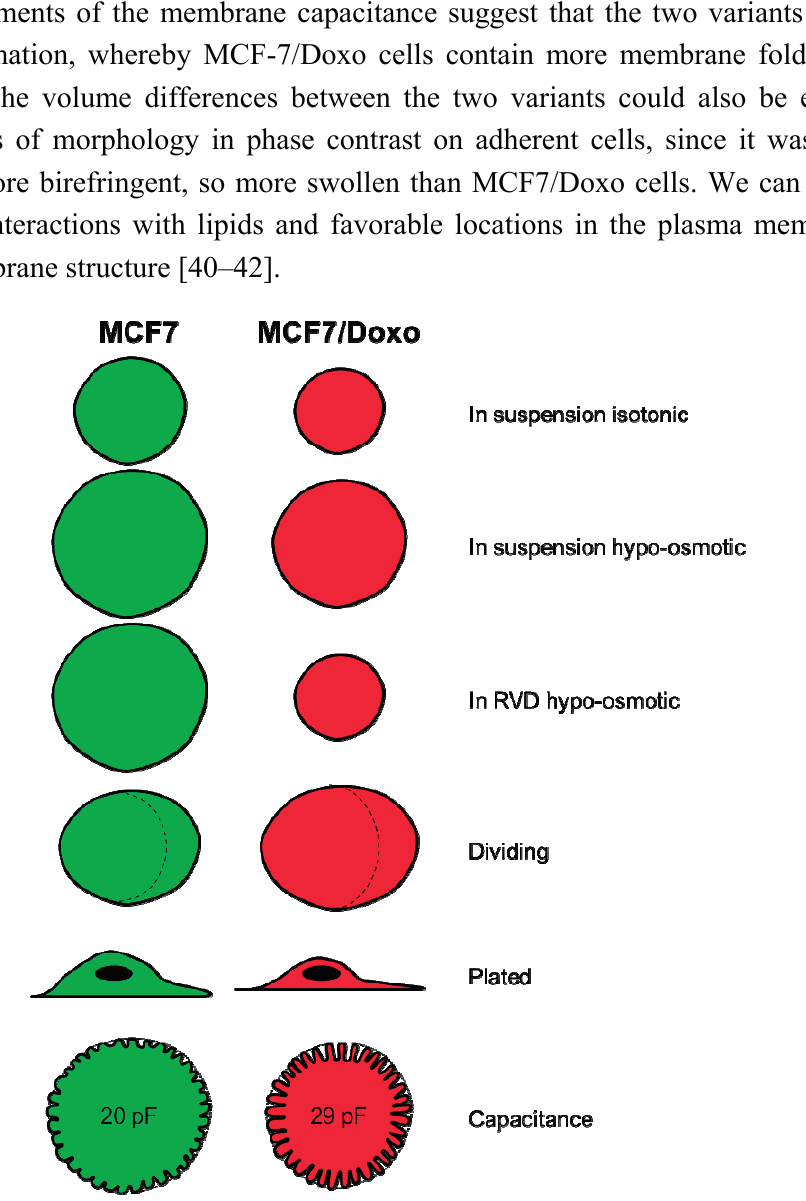
Figure 5. Schematic representation of MCF7 and MCF7/Doxo cells in each